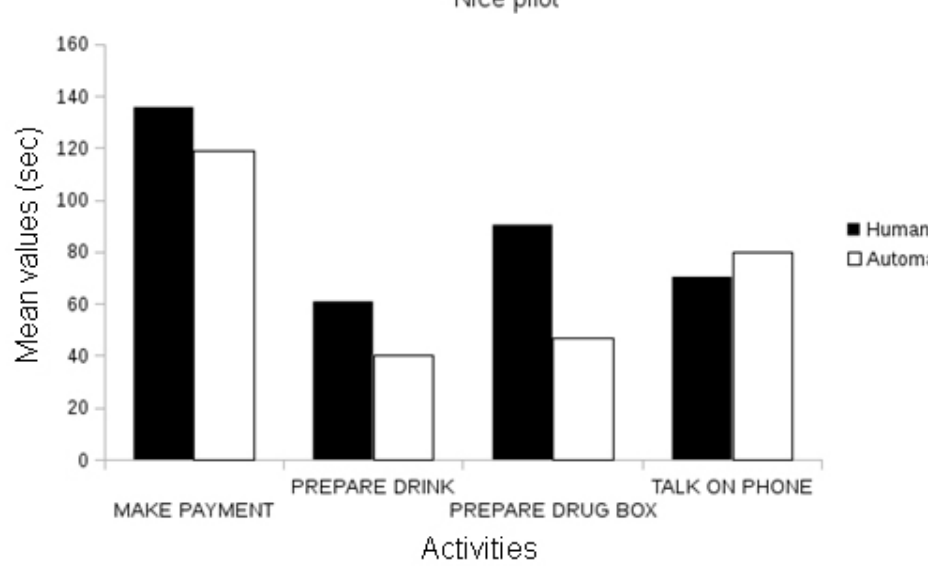
Figure 6. Comparison between the assessed duration (in seconds) of the automatically recognized events and the ground-truth data in the Nice Pilot.